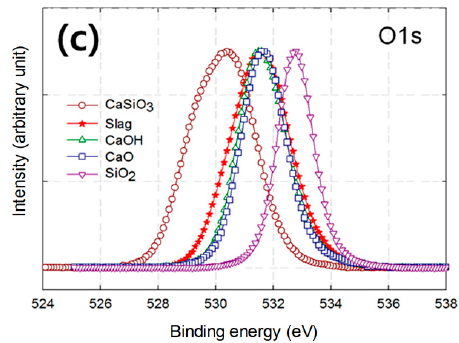
Figure 3. ( a ) Ca 2p, ( b ) Si 2p, and ( c ) O 1s XPS spectra of blast furnace slag.